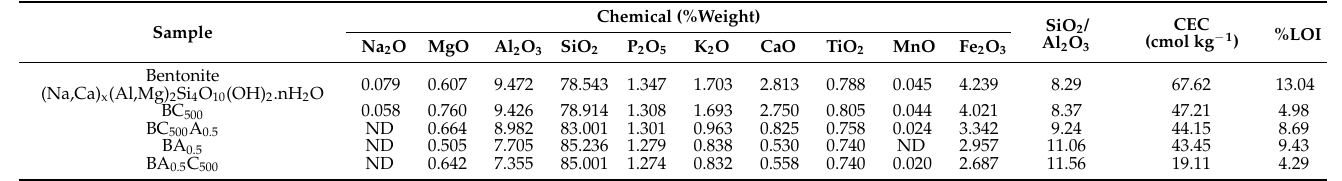
Table 1. Chemical composition and CEC values for bentonite and modified bentonite